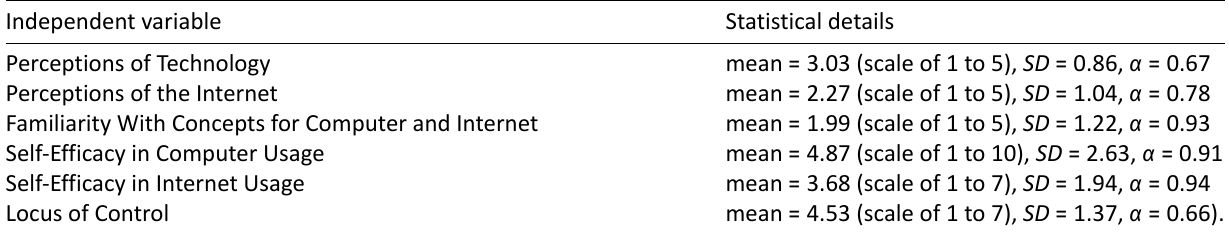
Table 1. Statistical details of independent study variables.